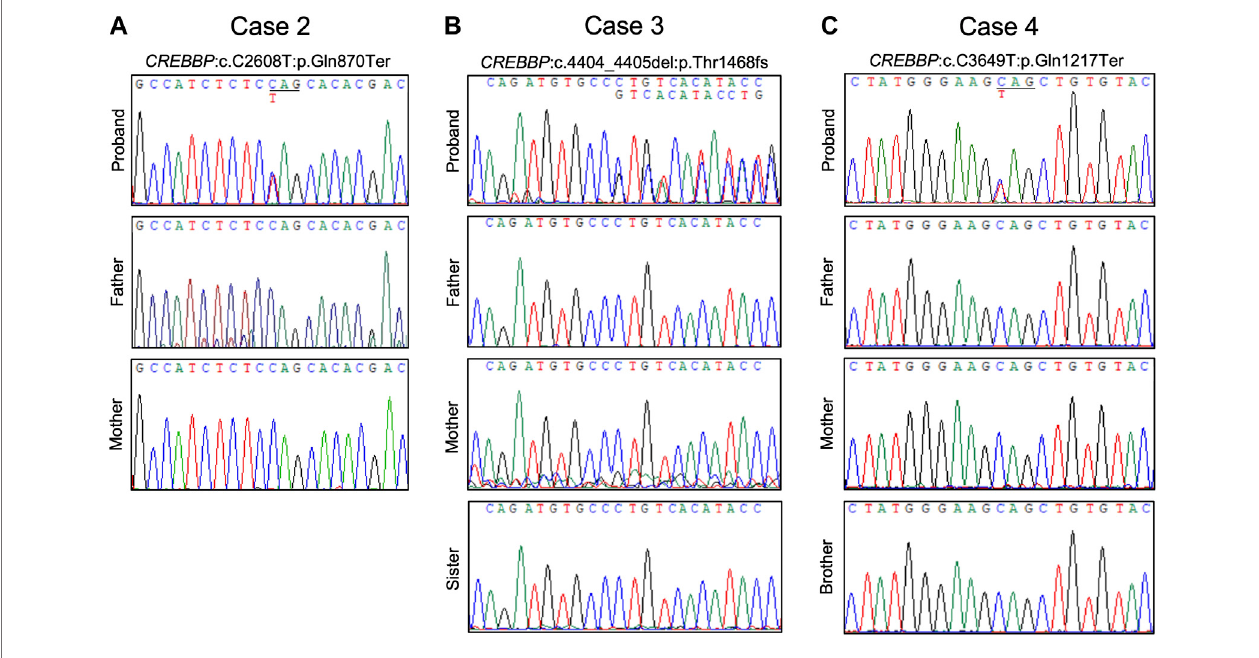
FIGURE 5 | Chromatograms of con fi rmative PCR-based Sanger sequencing and segregation analysis results. (A) A de novo nonsense CREBBP mutation in case 2. (B) A de novo CREBBP 2-bp deletion in case 3. (C) The CREBBP nonsense mutation was detected in both case 4 and the proband ’ s mother.